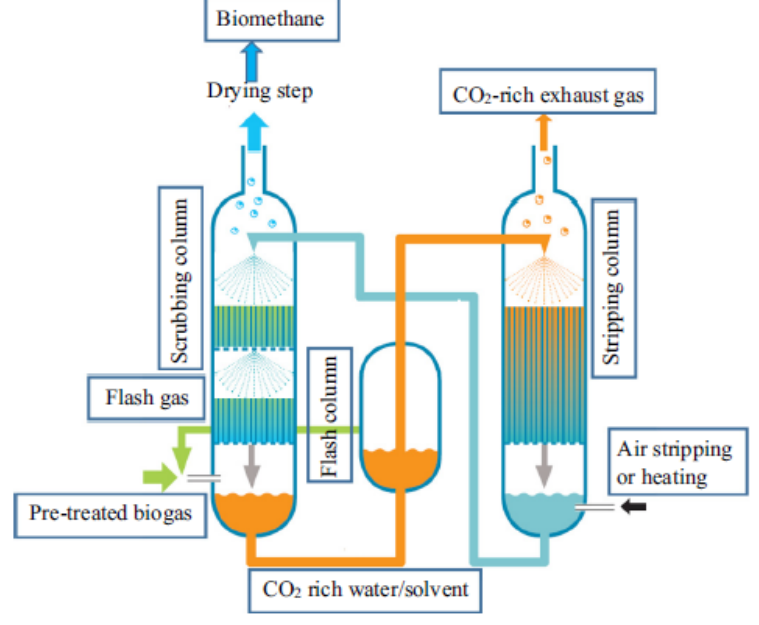
Figure 10. Scheme of the water scrubbing process [93] .